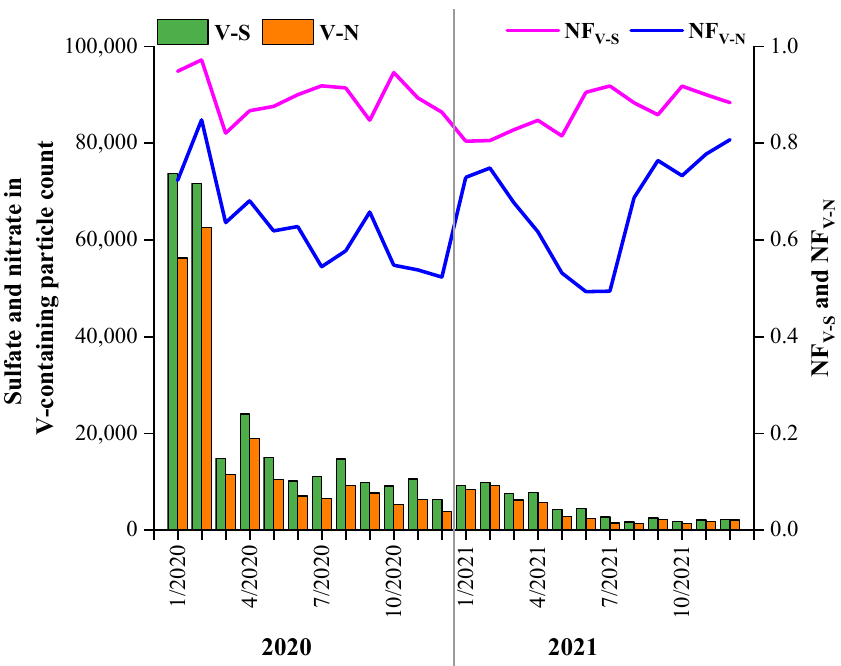
Figure 9. The number and proportion of sulfate and nitrate particulate matter in the V-containing particulate matter in 2020 and 2021. The bar graph shows the quantities and the line graph shows the percentages.